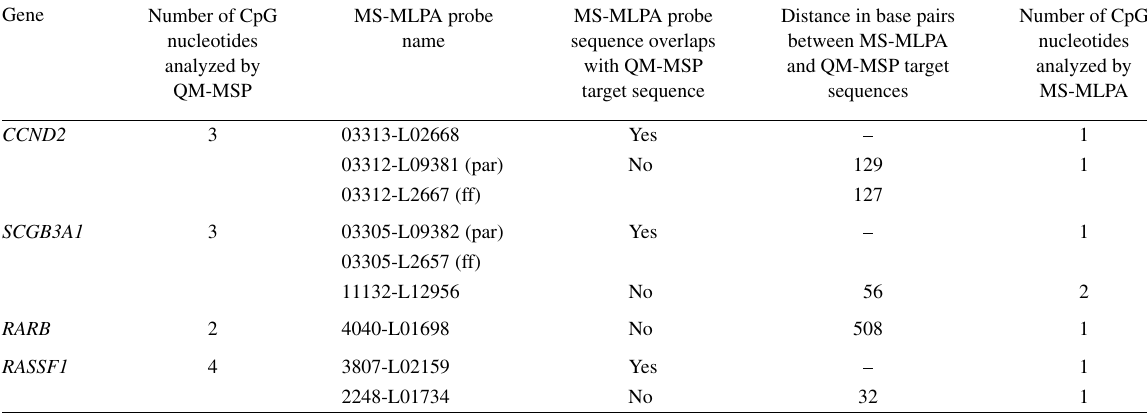
Genes used to compare different quantitative methylation assays and comparison of their target sequences (par = paraffin, ff = fresh frozen) Gene Number of CpG nucleotides analyzed by